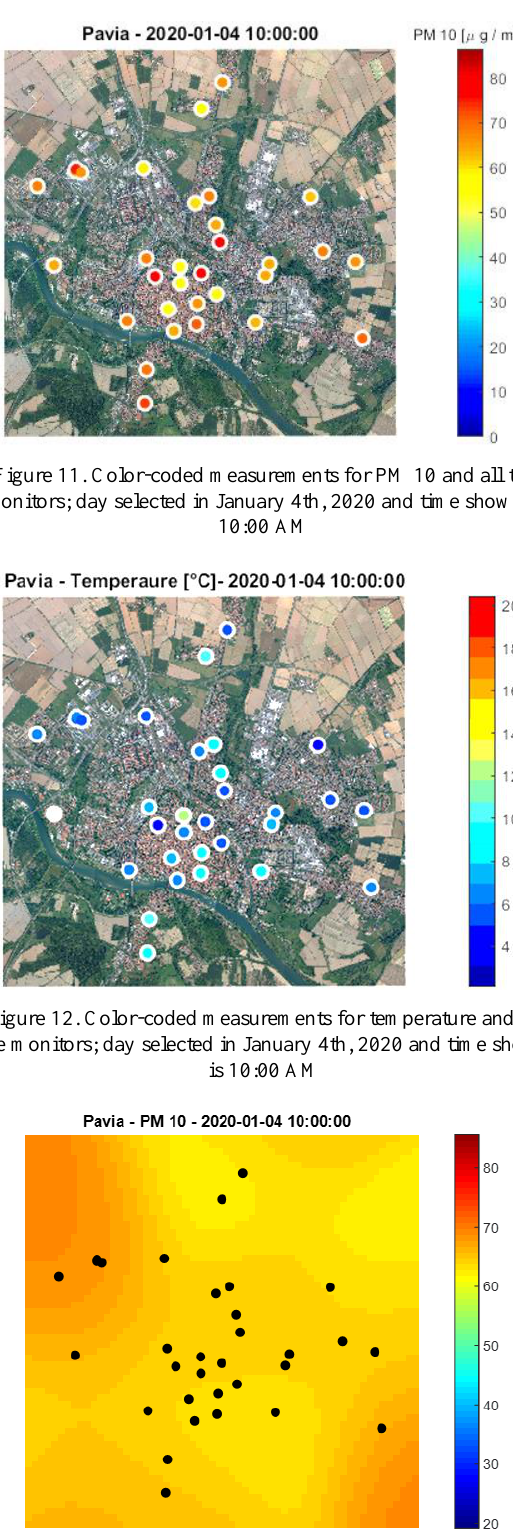
temperature; colour bar on the right side express the temperatures in Celsius degrees.